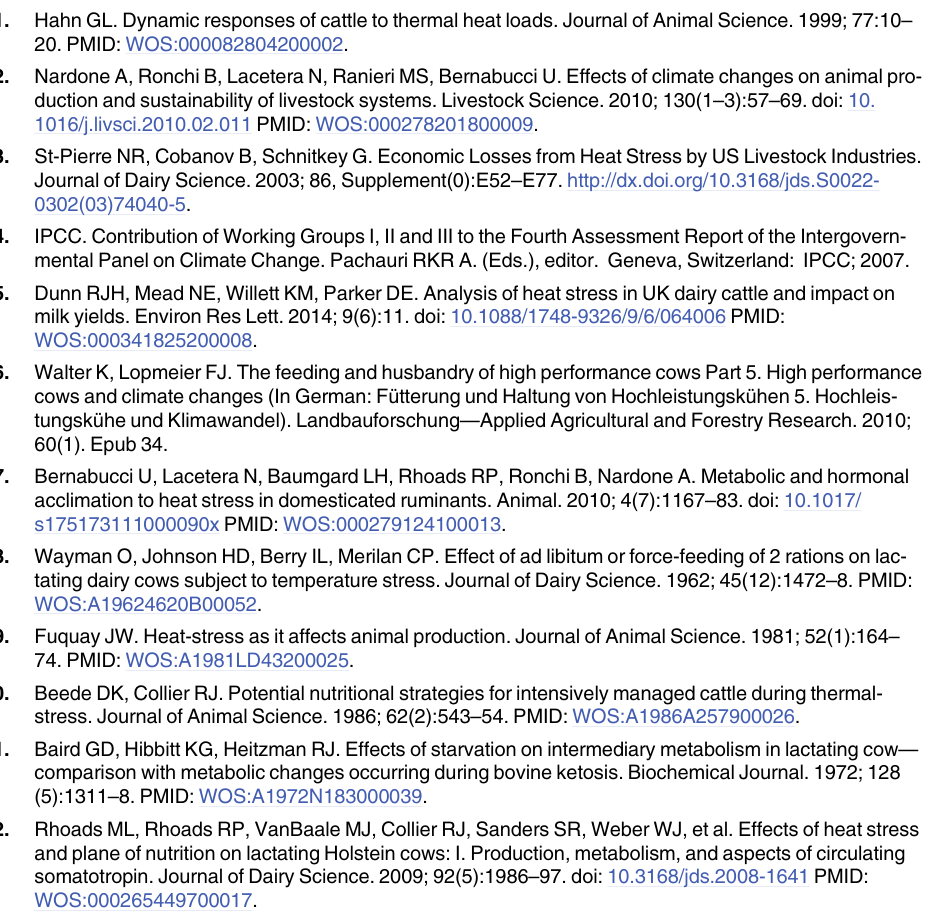
S3 Table. Complete dataset of Temperature Humidity Index (THI) and Dry Matter Intake (DMI) during Period 1 (P1) and Period 2